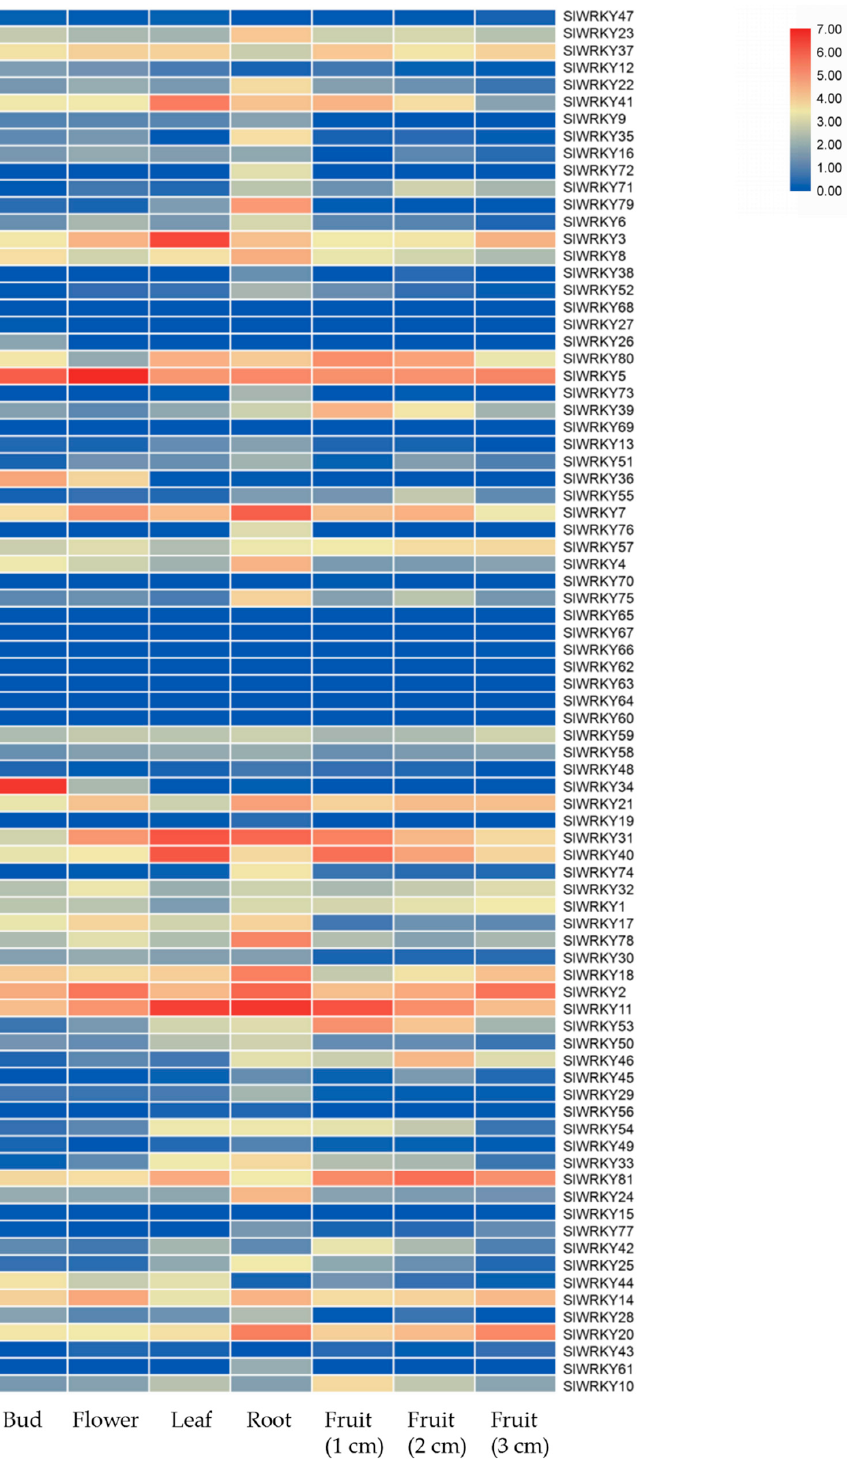
Figure 5. Heat map of differential expression of the WRKY transcription factor family genes in different tissues.